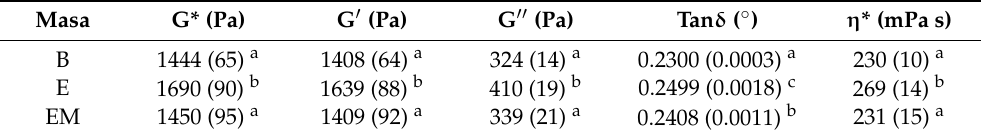
Table 1. Rheological parameters of the doughs (B: control; E: rose hip; EM: rose hip with maltodextrin). Masa G*